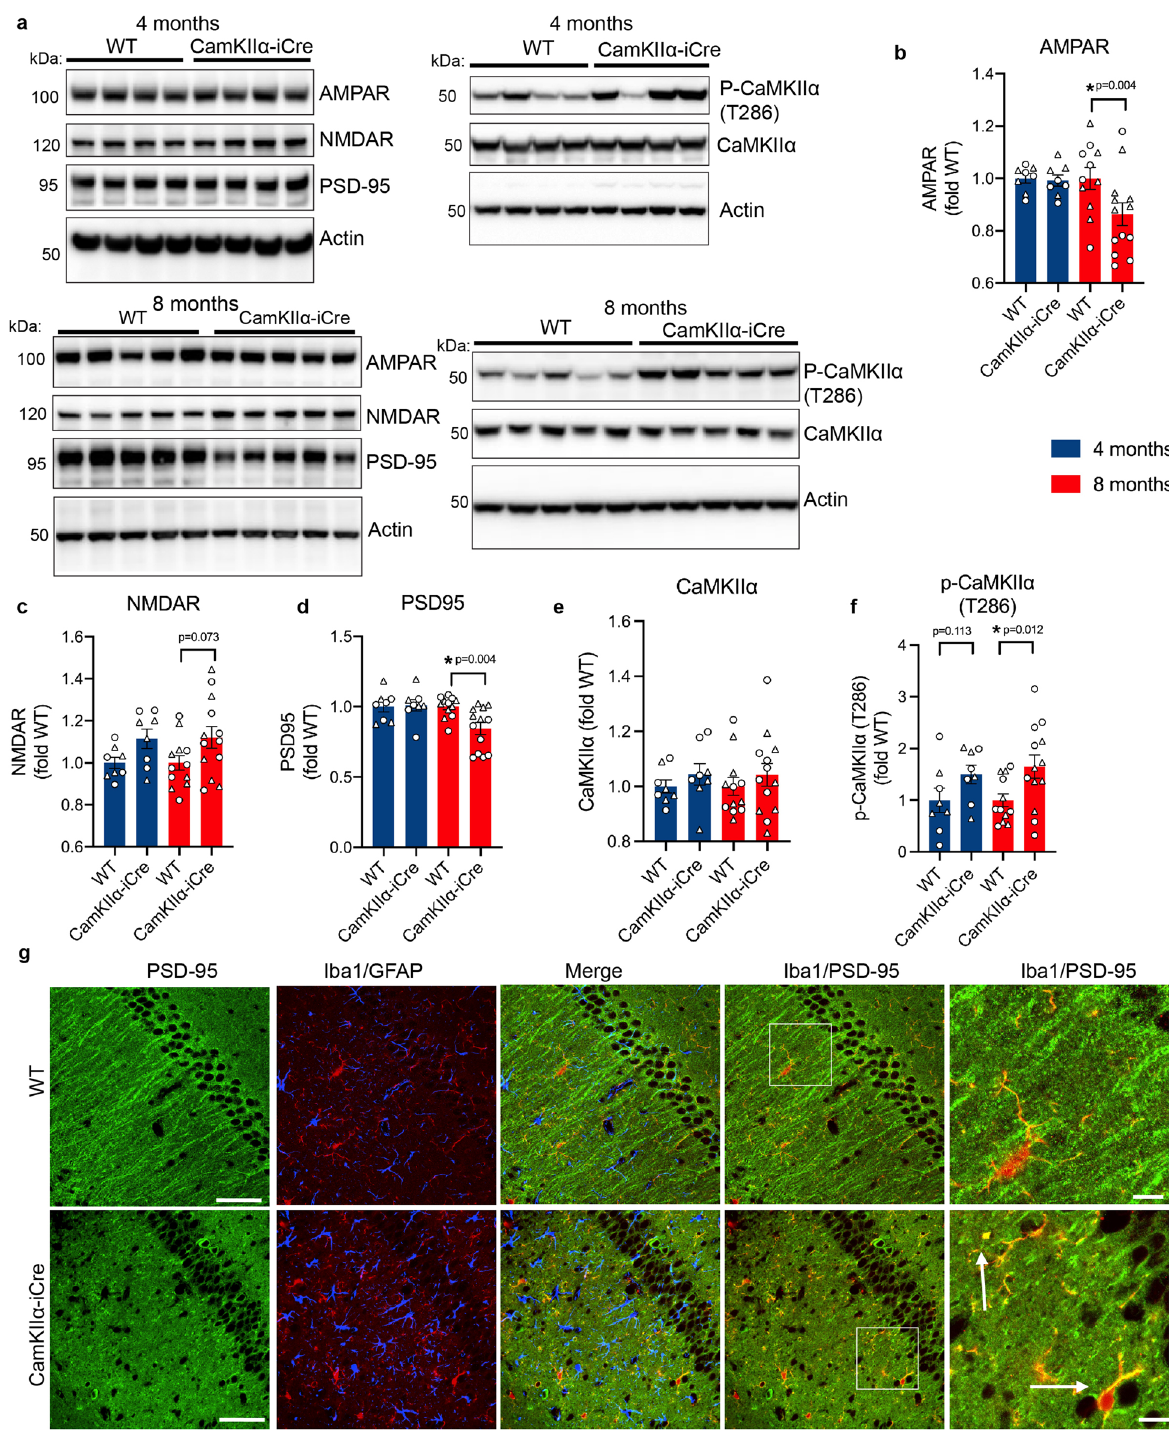
Figure 3. Post-synaptic proteins are altered in the hippocampus of CaMKIIα-iCre mice. (A) Immunoblot of hippocampal homogenates from 4-month-old (upper) and 8-month-old (lower) WT and CaMKIIα-iCre mice probed for AMPAR, NMDAR, PSD95, phosphorylated CaMKIIα (Thr286), total CaMKIIα and actin. Original immunoblots of 4-month-old mice are shown in Fig. S4A. Original immunoblots of 8-month-old mice are shown in Fig. S4B. Quantification of AMPAR (B) , NMDAR (C) , PSD95 (D) , total CaMKIIα (E) and phosphorylated CaMKIIα (Thr286) (F) immunoblots in A normalized to actin and expressed as fold of WT (WT, n = 12; CaMKIIα-iCre, n = 13). (G) Immunofluorescence microscopy of representative coronal brain sections showing the CA1 hippocampus from 8-month-old WT and CamKIIα-iCre mice labeled for PSD95 (green), Iba1 (red) and GFAP (blue), scale bars 50 µm. Magnified images show strong co-localization (yellow) between PSD95 (green) and Iba1 (red) depicted by arrows, scale bars 10 µm. Circles = females, triangles = males. Unpaired t-test was performed for all quantifications and values are mean ±